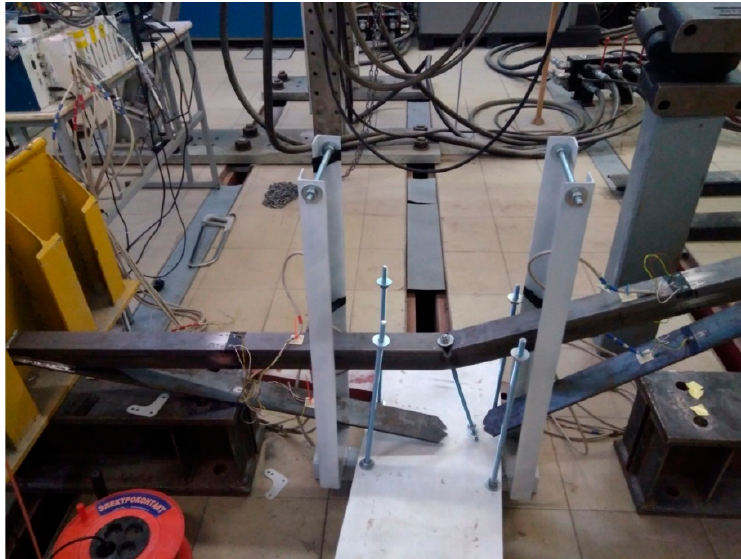
Figure 18. Truss after the destruction of the lower belt. Experiment No. 2.